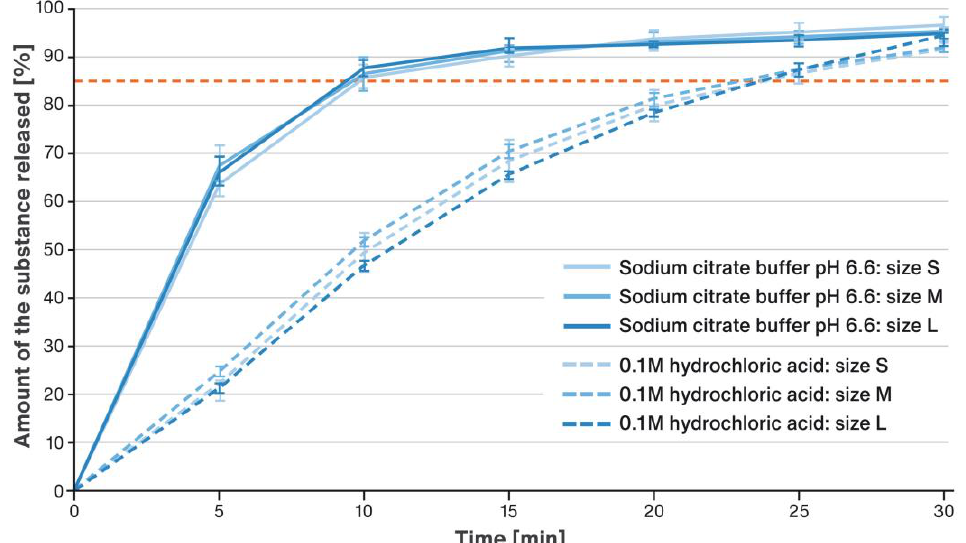
Figure 5. Comparison of the dissolution rate of RSC from a 40 mg sprinkle multiparticulates in 0.05 M sodium citrate buffer pH 6.6 (solid line) and 0.1 M HCl (dotted line); mean values of n = 6, SD is indicated by the error bars.